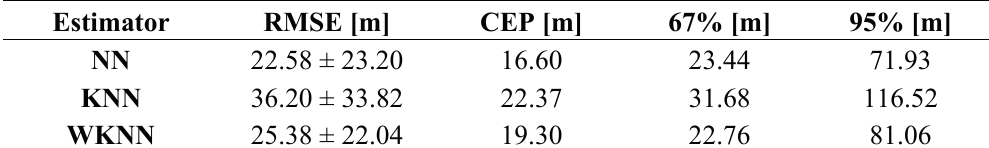
Table 6. Accuracy of the modular positioning system in an outdoor environment.